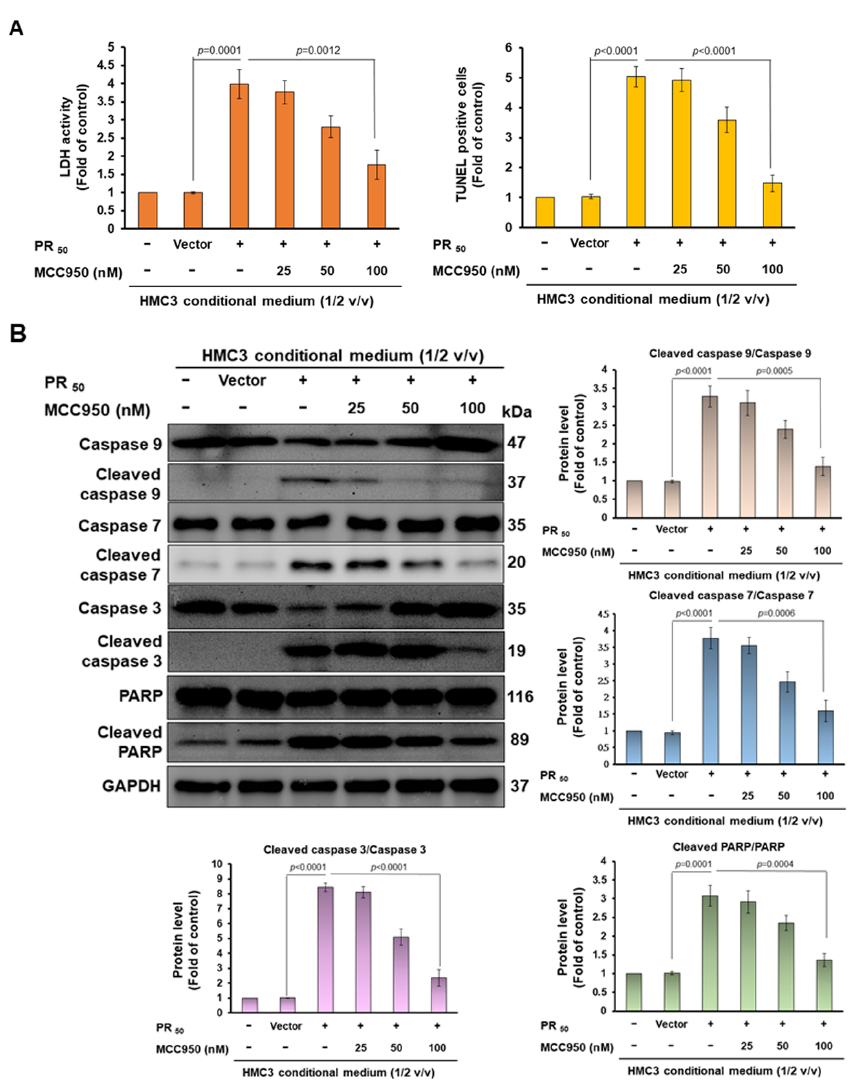
Figure 4. MCC950 treatment abolished the ability that conditioned medium of PR 50 -expressing HMC3 cells (PR 50 -CM) induced apoptosis in the mouse NSC-34 motor neuron cells. NSC-34 cells were treated with conditional medium of 0, 25, 50, or 100 nM MCC950-treated PR 50 -expressing HMC3 cells (PR-CM) at 1/2 ( v / v ) volume ratios for 24 h. ( A ) Cell death and apoptosis were measured by lactate dehydrogenase (LDH) release via ELISA and by apoptotic cells number via TUNEL assay, respectively. ( B ) Western blot was used to quantify the levels of apoptotic core proteins (left panel). ImageJ software was used to obtain the signal intensity of the image (right panel). The loaded inter- nal control is GAPDH.